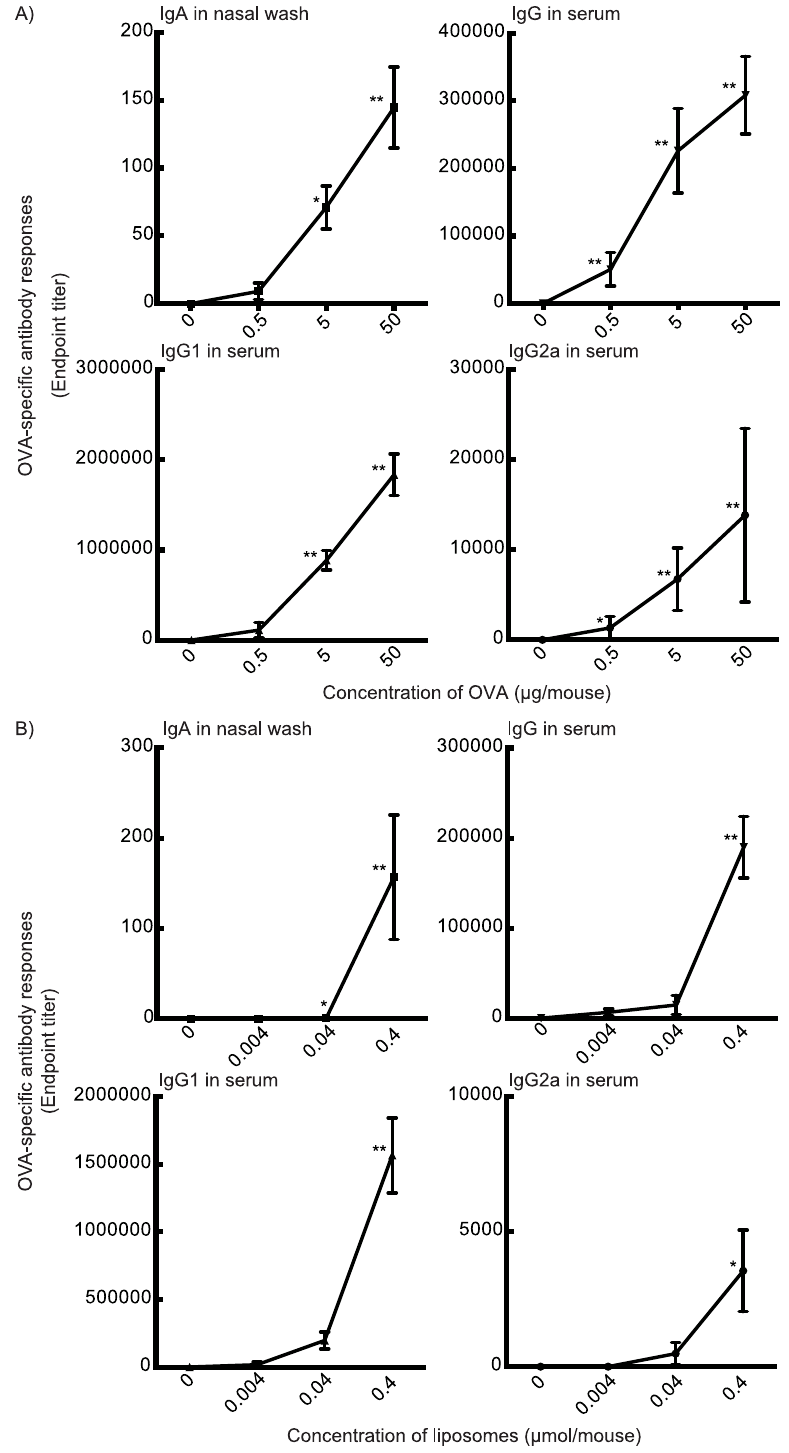
Fig 2. Cationic DOTAP/DC-chol liposome elicits dose-dependent OVA-specific antibody production depending on antigen (A) and liposome (B) concentrations. BALB/c female mice were immunized intranasally with various doses of OVA plus DOTAP/DC-chol liposomes on days 0 and 7. Serum was collected on day 14. The anti-OVA IgG, IgG1, and IgG2a levels in serum and anti-OVA IgA level in nasal washes were detected by ELISA assay. The data are obtained from at least three independent